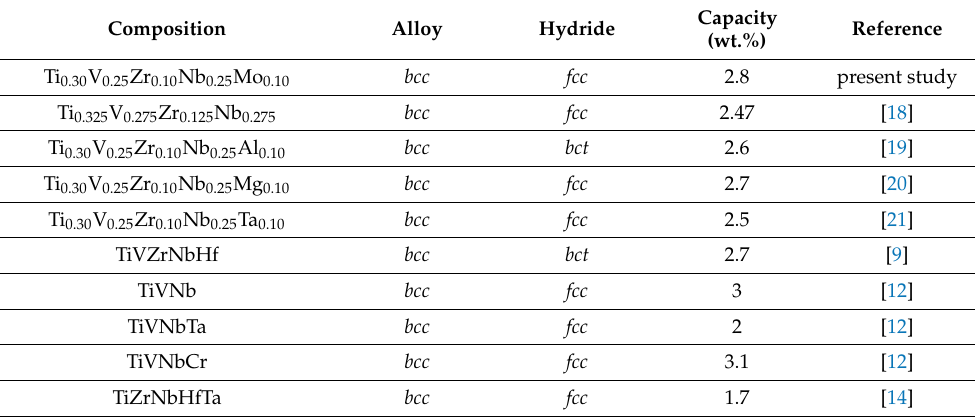
Table 2. Comparison of hydrogen storage properties of several refractory bcc HEAs. Composition